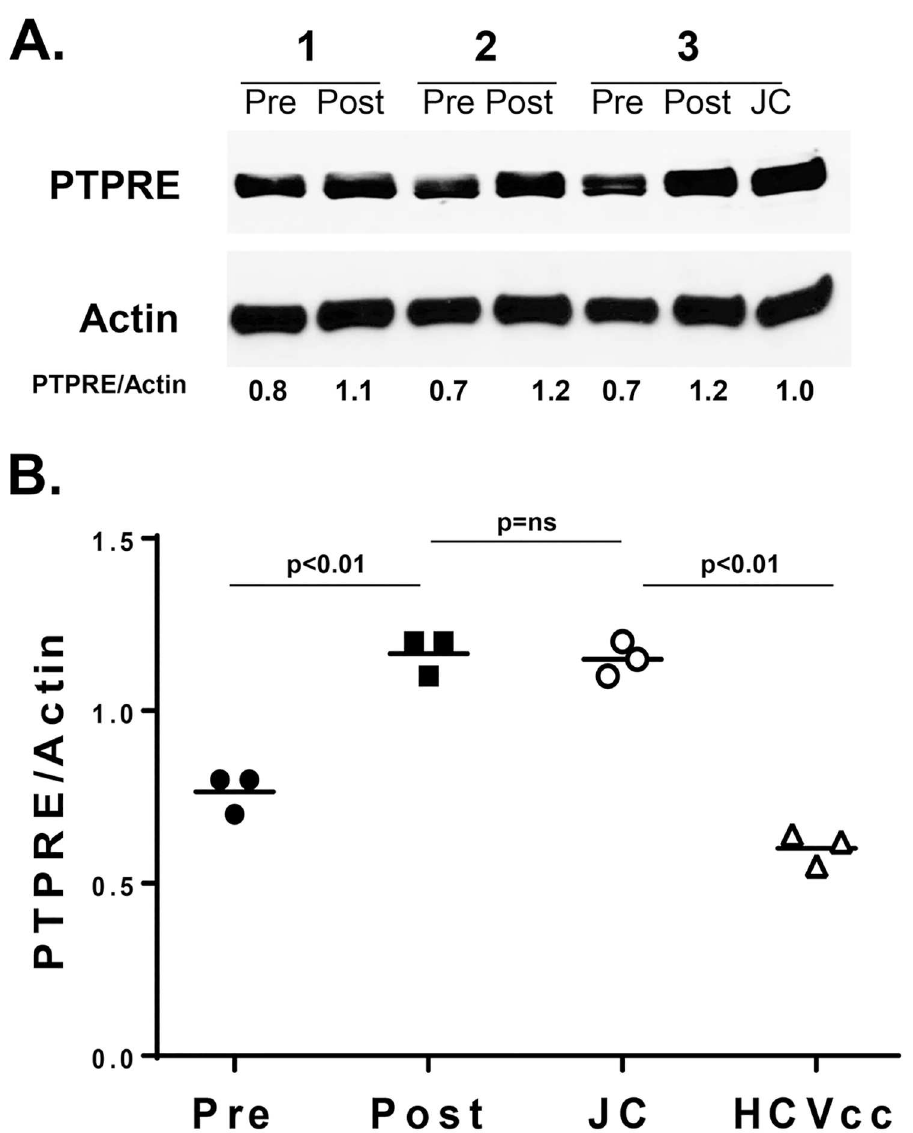
Fig 2. Serum and HCVccs regulate PTPRE in a human T cell line. Jurkat cells (2 x 10 6 ) were incubated with serum obtainedfrom three HCV-infected patients obtainedprior to (Pre) or following(Post) curative HCV treatment for 24 hours. Total cellularPTPRE and actin expressionwas measuredby immune blot (A). Alternatively, Jurkat cells were incubatedin a preparation of Huh7.5 cell culture generated,infectiousHCV particles (HCVccs), or in media (JC), and relative expressioncomparedto actin determined.Data represent results from three independent